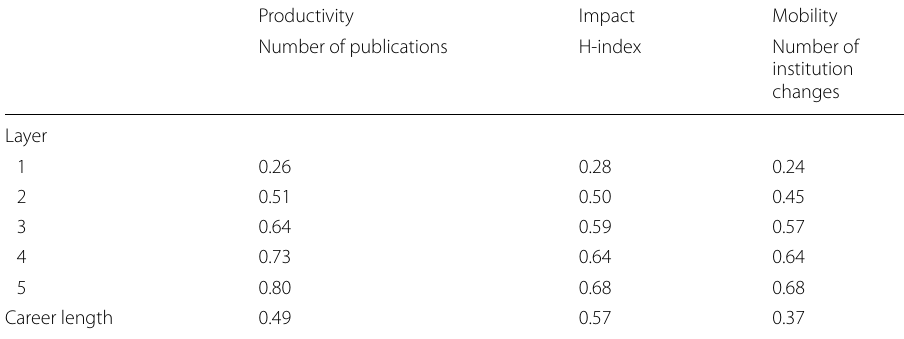
Each cell contains the Pearson correlation value for the corresponding layer and